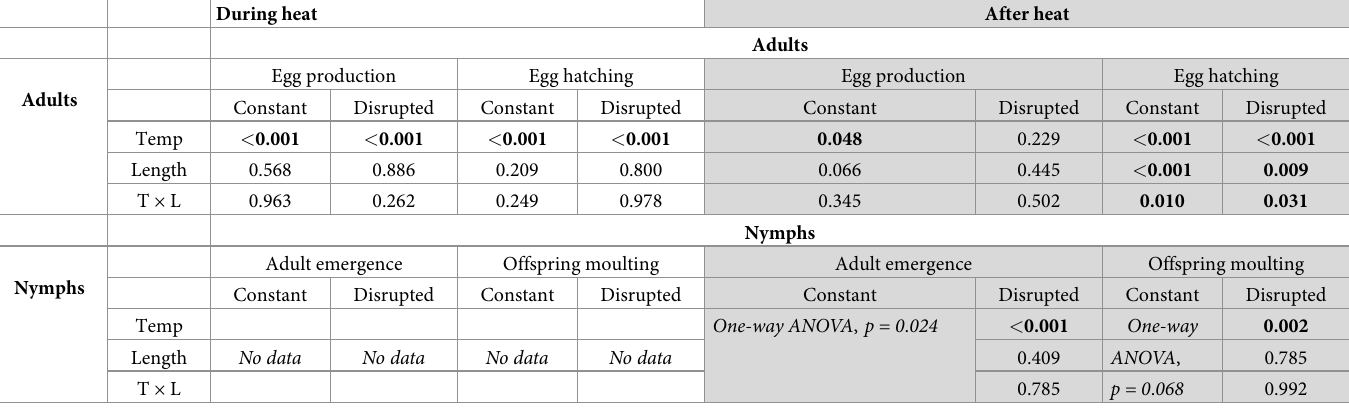
Table 1. Effects of heat stress on Cimex lectularius population development.